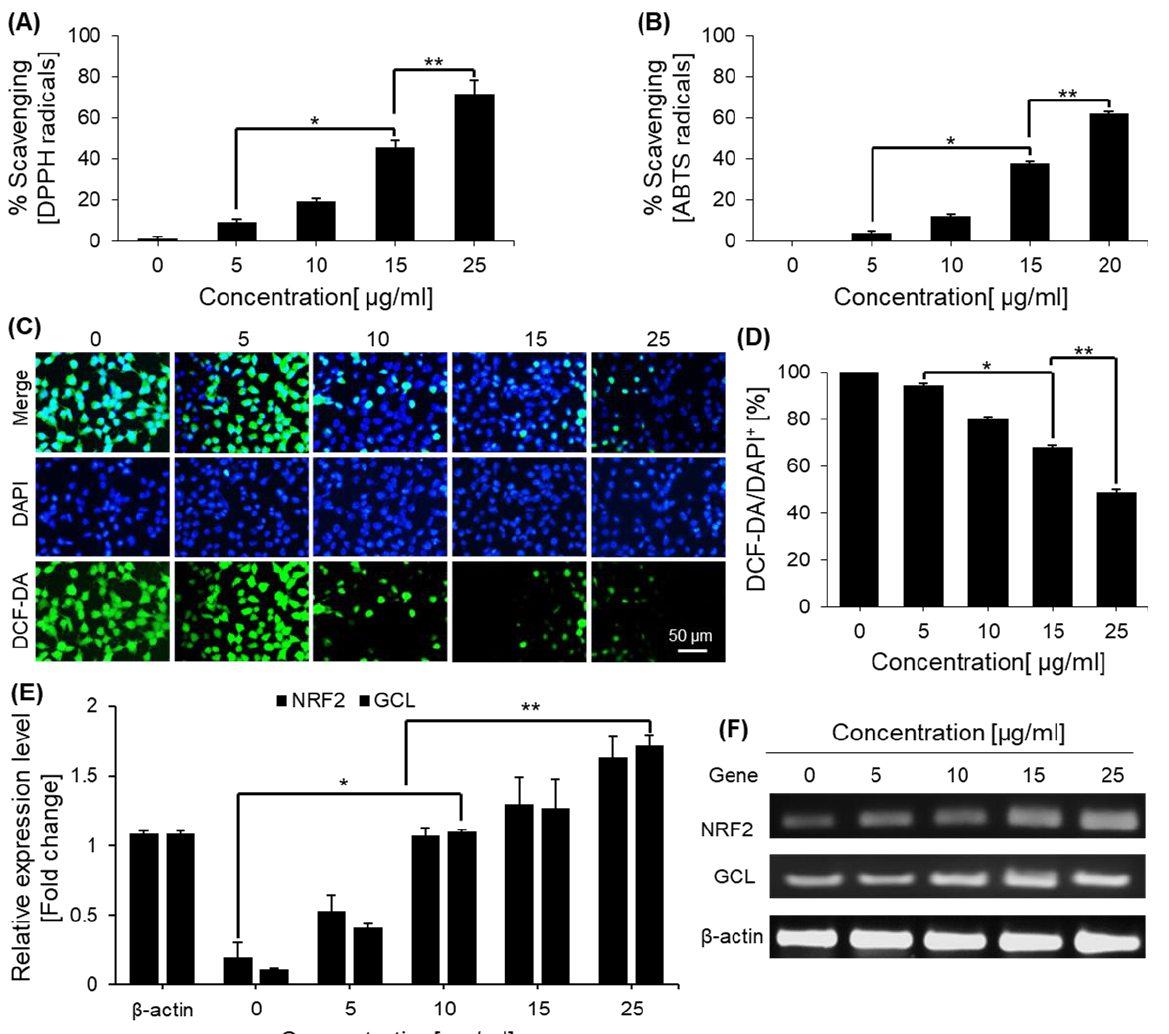
Figure 4. Antioxidant potential of saponins against free radicals, ROS, and the expression of antioxidant genes in HEK293 cells. ( A ) Free radical scavenging activities of saponins against DPPH free radicals. ( B ) Free radical scavenging activities of saponins against ABTS free radicals. ( C ) Determination of H2O2-induced cellular ROS in control and saponin-treated cells using dichlorodihydroflu- orescein diacetate (DCFDA) staining under a fluorescence microscope. ( D ) DCFDA-positive cells per 4 (cid:48) ,6-diamidino-2-phenylindole (DAPI)-positive cells were quantified in the control and saponin- treated cells. ( E ) Antioxidant-associated gene expression was determined in treated and control cells determined RT-PCR. ( F ) Gel electrophoresis of the PCR products from the antioxidant-related gene RT-PCR. The data are shown as the mean ± SEM of three separate experiments. * = p < 0.01 and ** = p < 0.001 compared with the